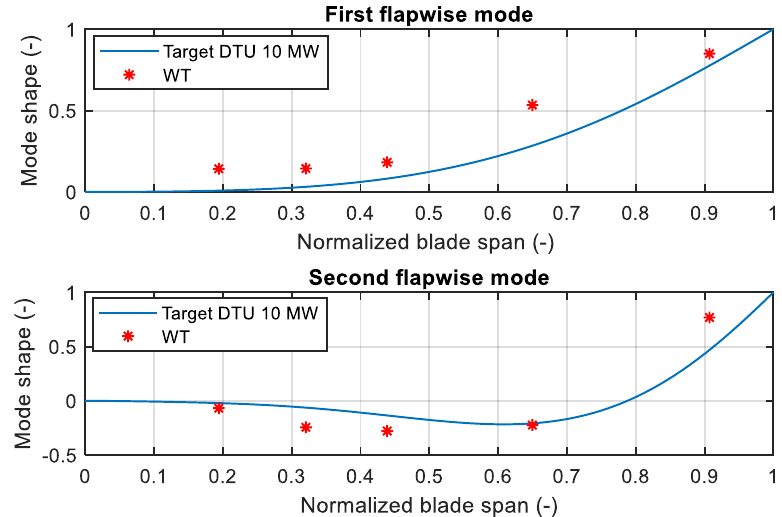
Figure 10. First and second flapwise mode shapes of the wind tunnel scale model blade from the experimental modal identification.